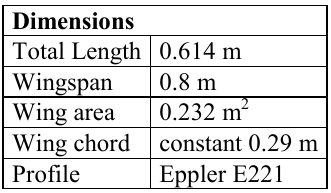
Table 2. Weights of Mini-UAV’s